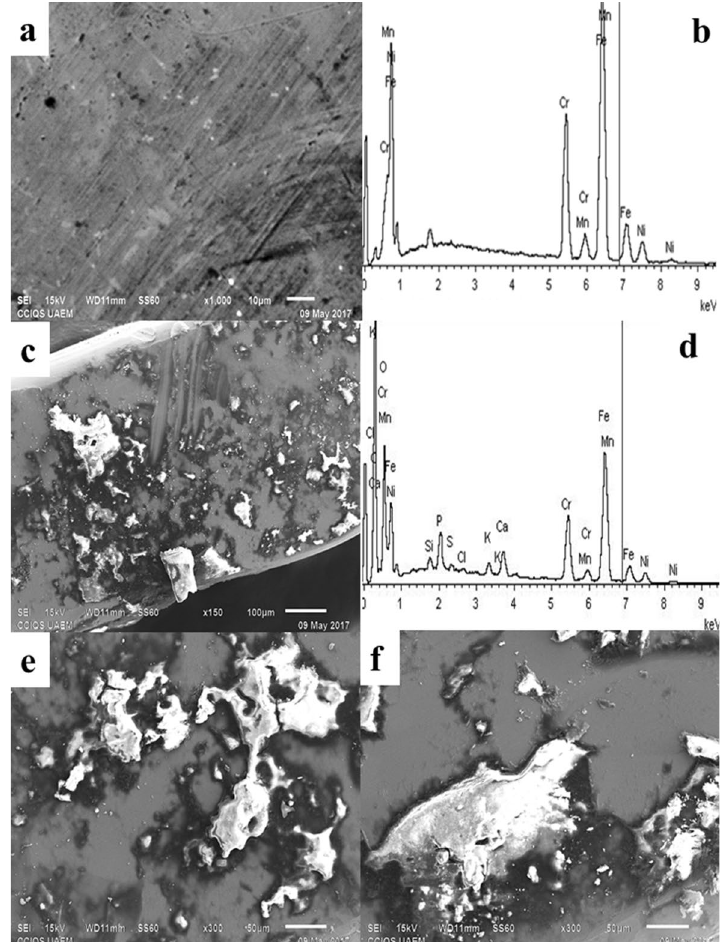
Figure 4. The 0.016 × 0.022 ″ stainless steel arc using SEM. ( A ) Reference sample of the arc surface. ( B ) EDS of the reference sample. ( C ) Arc surface after 1 month placement in the oral cavity. ( D ) EDS arc stainless steel after a month placement. ( E ) Surface arc increase ×300 and size of 50 µm. ( F ) Surface corrosion with increased ×300 and a size of 50